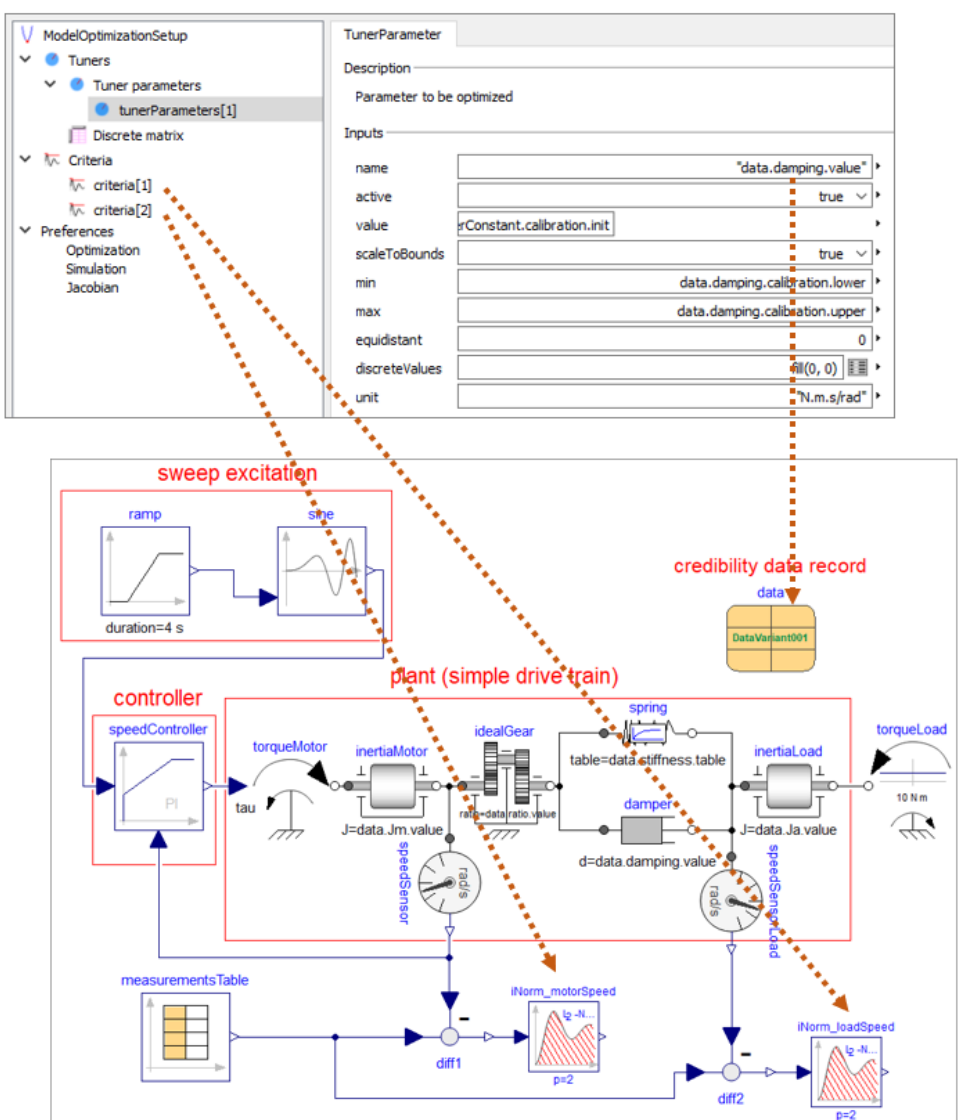
Figure 9. The bottom of the figure shows the model used for calibration . It consists of a sweep excitation block that generates a sine sweep with constant amplitude and increasing frequency as reference value for the feedback controller. The controller commands a motor torque for the drive train. Two sensors measure the angular velocities of the motor and load inertias. Measurement data are provided as Table measurementsTable and the criteria for the optimization-based calibration of the damping parameter is calculated by the integral over the L2-norm of the difference between simulated and measured data. The upper part of the figure shows a screenshot of the user interface for the calibration setup with DLR’s Optimization Library. The initial value of the damping parameter d , as well as its lower and upper bounds, is directly set by using the information stored in the data record of the drive